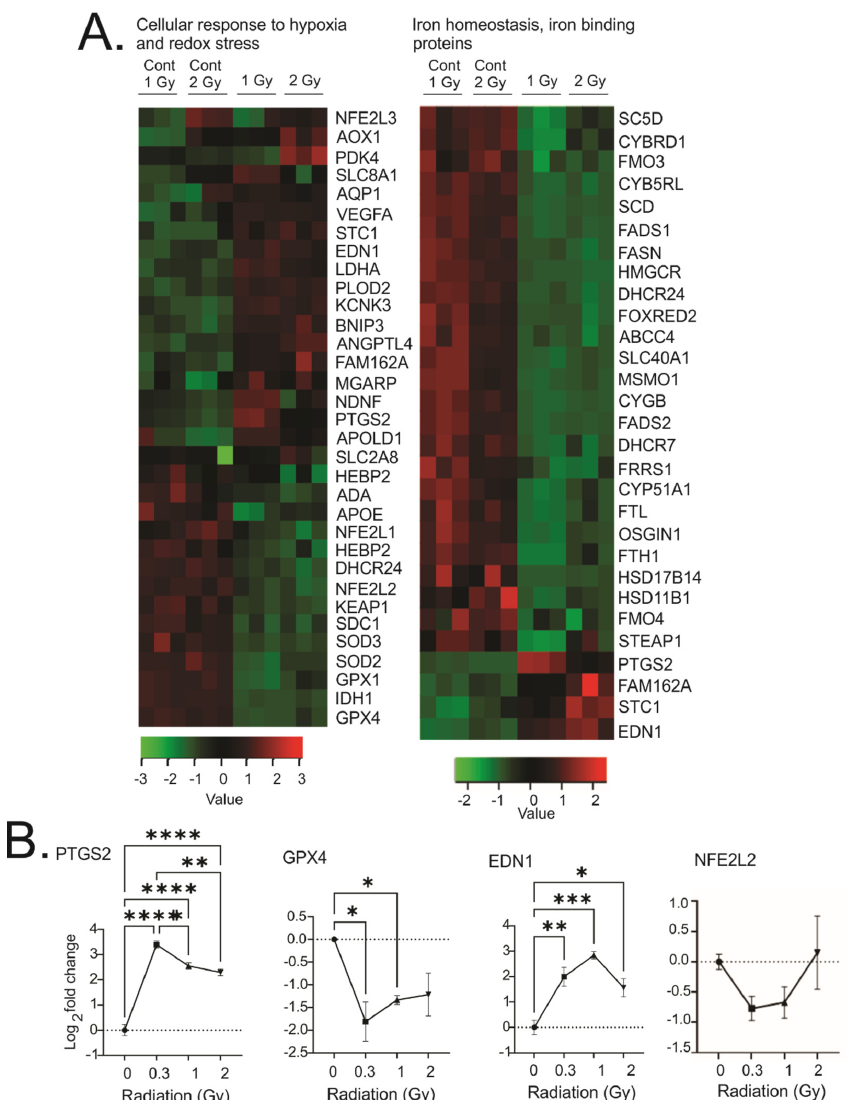
Figure 9. Heatmaps of gene expression changes for pathways involved in cellular response to hypoxia or redox stress and iron homeostasis and iron-binding proteins. ( A ). RNAseq was used to identify gene expression changes in primary human MSCs following 1 or 2 Gy (0.66 cGy/h) 60 Co irradiation. Control cells were cultured under identical conditions for 1 or 2 weeks. GO analysis was performed using DAVID and heatmaps were generated using genes with q < 0.05. Rows are centered and unit variance is applied to rows. ( B ). qPCR gene regulation using log base 2 scale fold change of genes supporting heatmaps of pathways. Data show averages ± SEM from N = 3 biological replicates with two technical repeats. * indicates p < 0.05, ** indicates p < 0.01, *** indicates p < 0.001, **** indicates p < 0.0001, respectively, compared with sham-irradiated control cells.